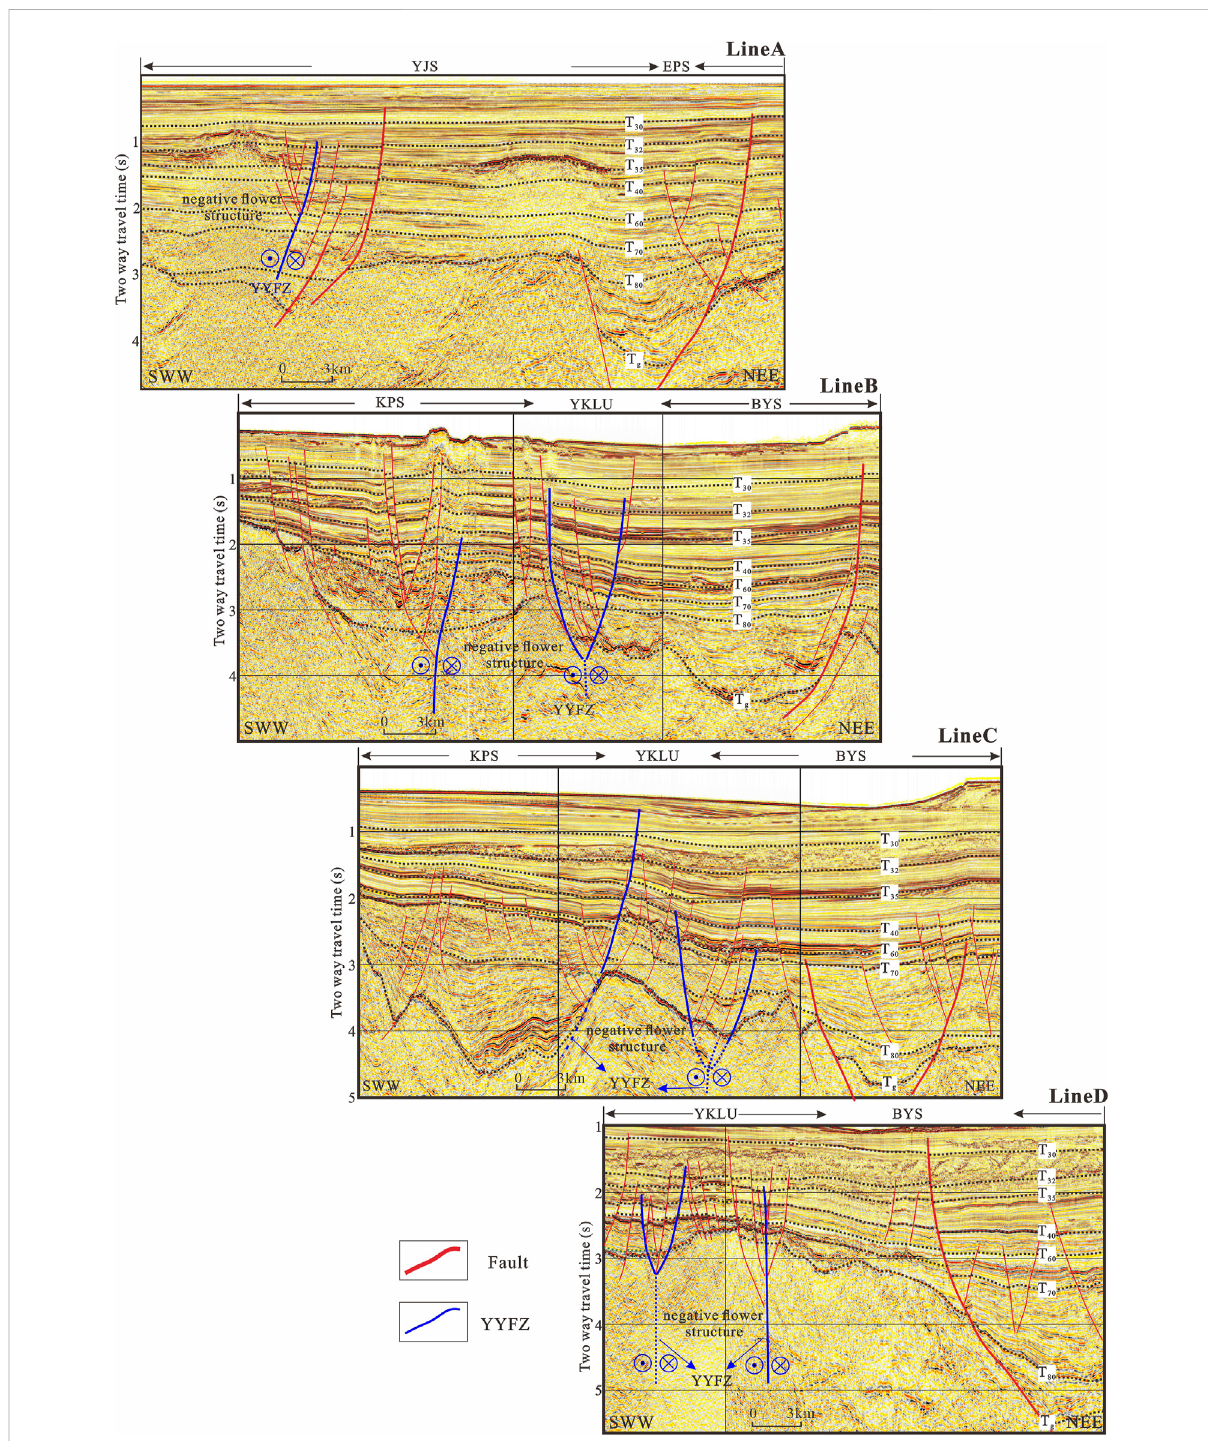
FIGURE 5 Structure, fault system, and stratum characteristics of the YYFZ. Pro fi le locations are shown in Figure 2. The faults derived from the YYFZ terminate mainly in N 2